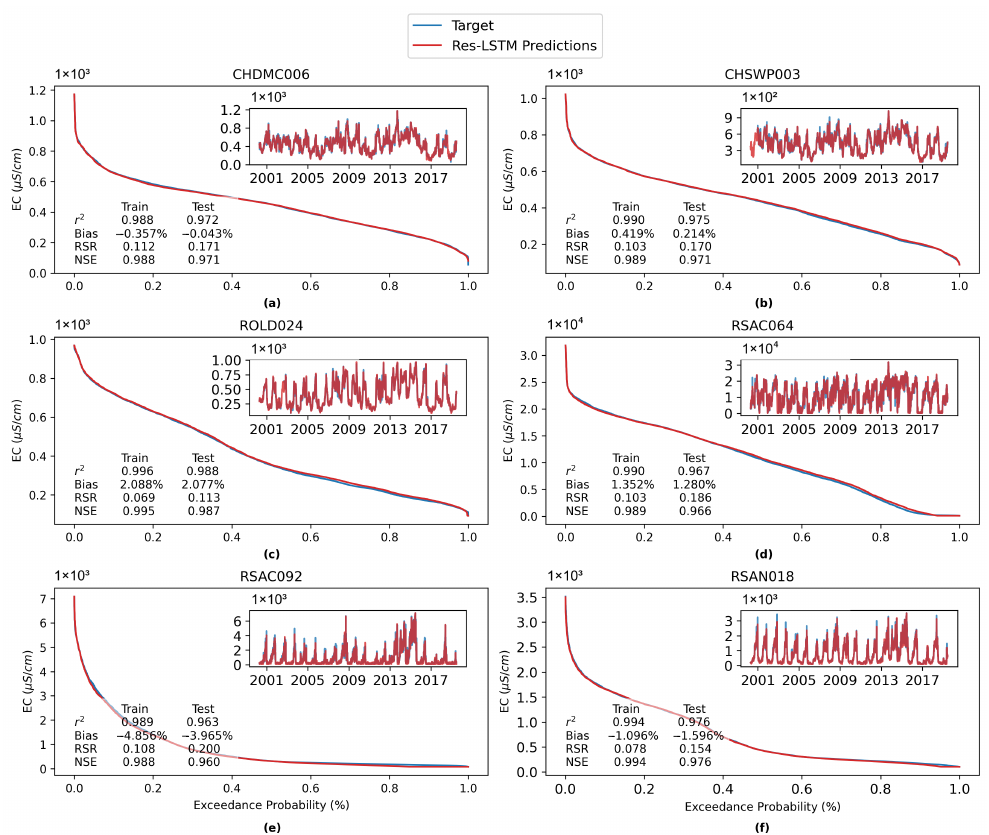
Figure 6. Exceedance probability plot and time series plot of Res-LSTM simulated versus observed salinity at daily time step.